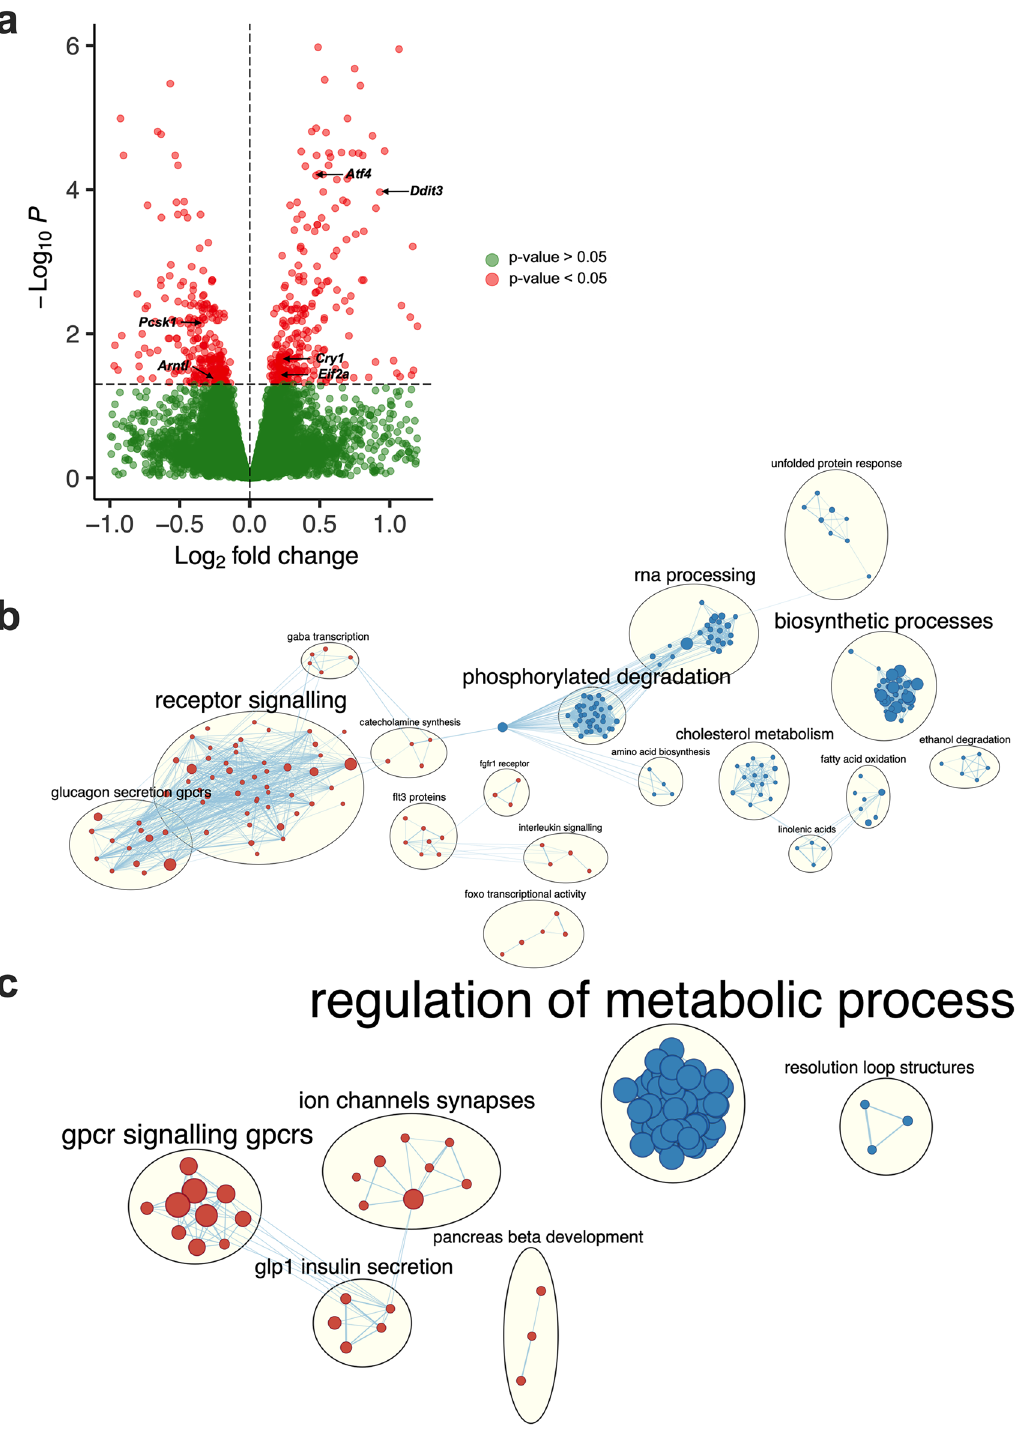
Figure 2. Nobiletin improves mGLUTag L cell metabolic processes following palmitate-induced disruption. ( a ) Volcano plot of the transcriptome at the peak (8 h) time point of GLP-1 secretion in synchronized palmitate-treated as compared to vehicle (control) mGLUTag L cells. ( b , c ) Network analysis comparing pathway enrichment between transcriptomes of ( b ) vehicle- and palmitate-treated, and ( c ) palmitate- and palmitate + nobiletin-treated mGLUTag L cells at the peak (8 h) GLP-1 secretory time point. Orange dots indicate pathways enriched to the vehicle ( b ) or palmitate ( c ) conditions; blue dots indicate pathways enriched to the palmitate- ( b ) or palmitate + NOB ( c ) treatment, with the size of the dot indicating the number of genes contained in the pathway. n =